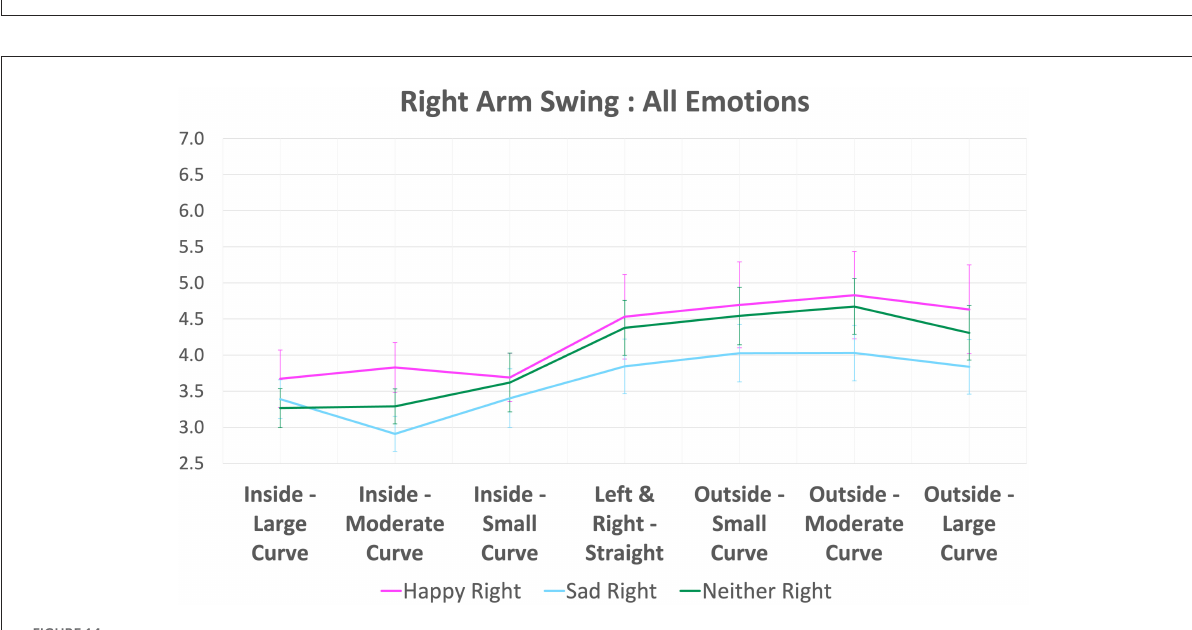
According to the above results, for left arm swings, the β values from linear regression of happy and sad are largely different ( β = 0.0259 and β = 0.0038, respectively). The results suggest that the left arm swing magnitude when the subjects feel happy is much different from the left arm swing magnitude when the subjects feel sad, since the slope of these two emotions are significantly different. In addition, for right arm swings, the β values of happy and sad are also different, but the difference in